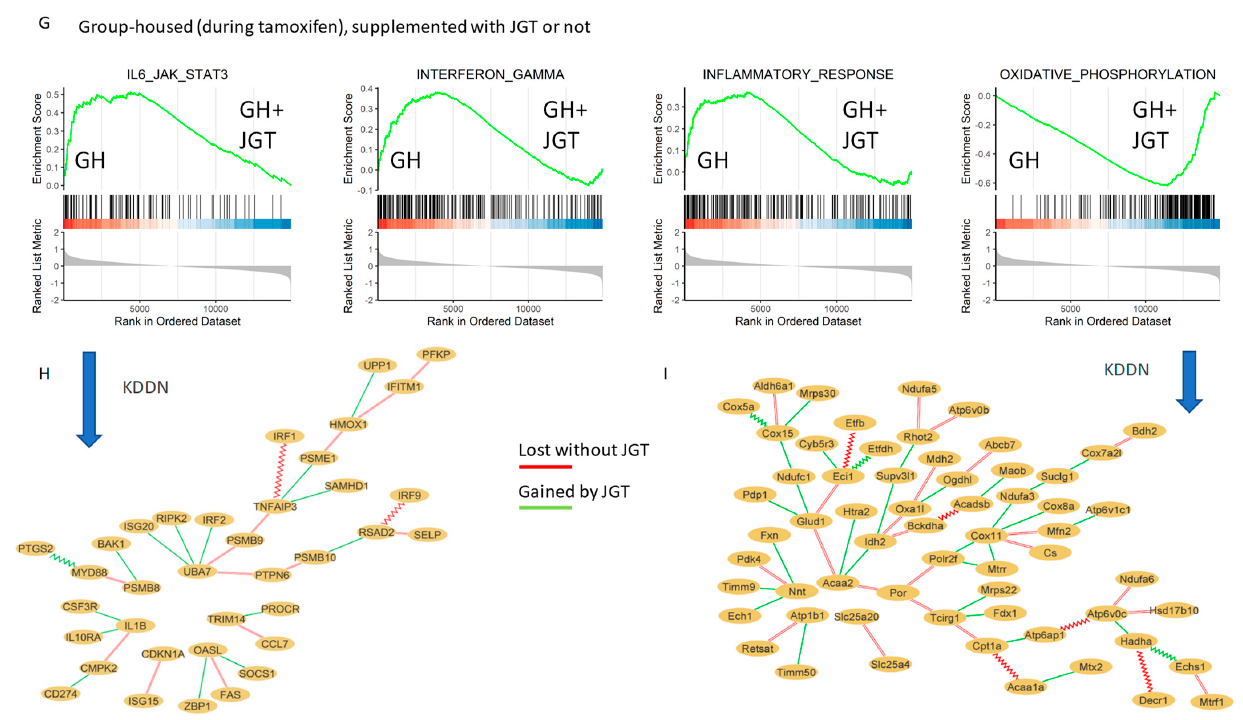
Figure 3. Alterations in the Cancer Hallmark pathways in RNA sequencing analysis in the mam- mary glands in the group-housed (GH) and socially isolated rats (SI). ( A ) After tamoxifen (TAM) therapy, social isolation increased the IL6/JAK/STAT3, INF γ , and inflammatory response Hallmark pathways and inhibited the oxidative phosphorylation (OXPHOS) pathway, compared with group housing. ( B , C ) Knowledge-fused differential dependency network (KDDN) analysis of genes in the IL6/JAK/STAT3 and OXPHOS signaling pathway, respectively, in GH vs. SI rats. Yellow ovals indi- cate nodes. Red line represents gene–gene interactions that only exist in GH group (lost in SI) and the green line represents gene–gene interactions that only exist in the SI group (gained in SI). ( D ) Adding Jaeumganghwa-tang (JGT) reversed all of these changes in SI rats. ( E , F ) KDDN analysis of genes in the IL6/JAK/STAT3 and OXPHOS signaling pathway, respectively, in SI vs. SI + JGT rats. Red line represents the gene–gene interactions that only exist in the SI group (lost without JGT) and the green line represents the gene–gene interactions that only exist in the SI + JGT group (gained by JGT), ( G ) During tamoxifen therapy, JGT had similar e ff ects on the IL6/JAK/STAT3, INF γ , in fl am- matory response, and OXPHOS Hallmark pathways in GH rats than it did in SI rats after tamoxifen therapy. ( H , I ) KDDN analysis of genes in the IL6/JAK/STAT3 and OXPHOS signaling pathway, re- spectively, in GH without JGT vs. GH + JGT. Red line represents the gene–gene interactions that only exist in the GH group (lost without JGT) and the green line represents the gene–gene interac- tions that only exist in the GH + JGT group (Gained by JGT). Jagged green and red lines represent the connection also available in the protein interaction database.